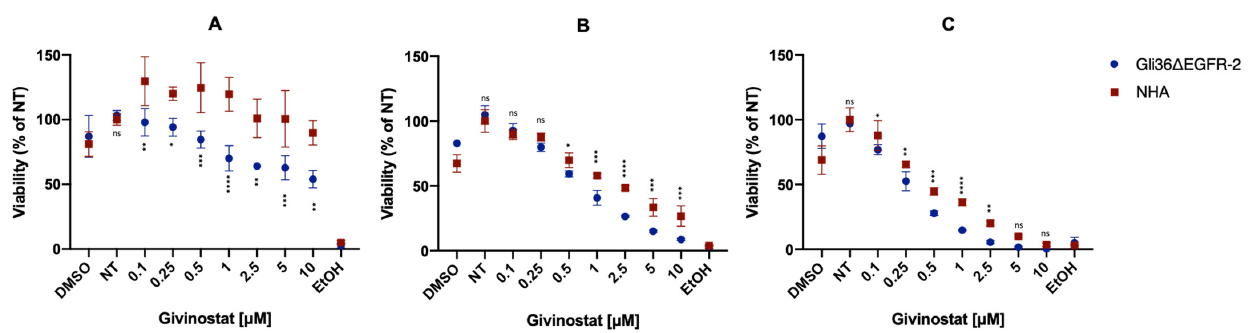
Figure 3. Evaluation of the cytotoxicity on Gli36 Δ EGFR ‐ 2 and NHA cell lines treated with free